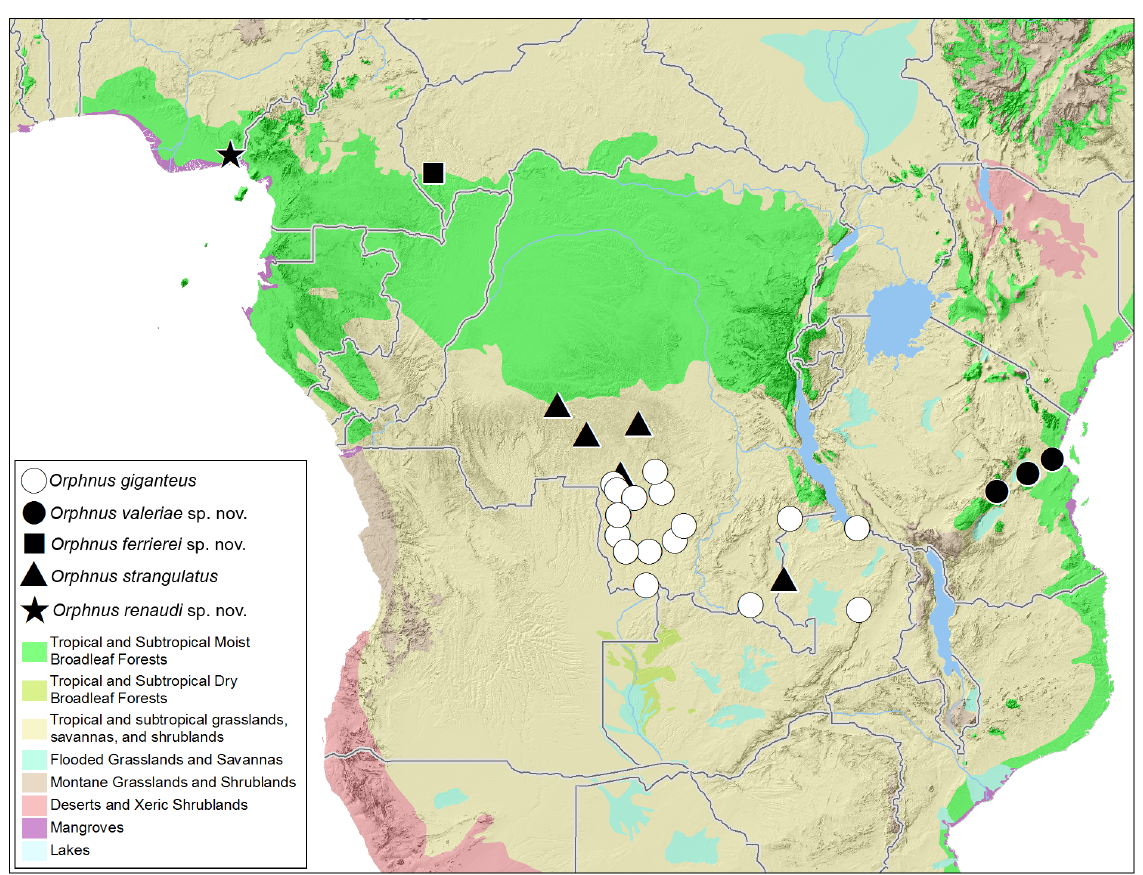
Fig. 6. Orphnus ( Phornus ) spp. Locality map. Orphnus parastrangulatus sp. nov. is not mapped,